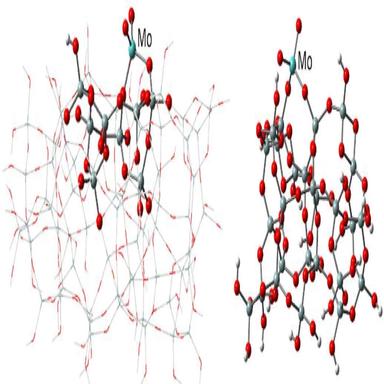
Example cluster models of the dioxo Mo(VI) species on the partially dehydroxylated silica surface. In the first case, the ONIOM partitioning scheme is applied. Adapted with permission from ref.. Copyright © 2012 American Chemical Society.